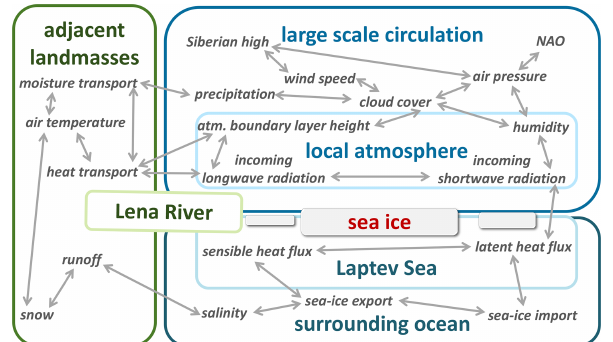
Figure 1. The regional climate system can be divided into general components (Laptev Sea, local atmosphere, adjacent land), which are embedded in the global climate system (surrounding ocean, atmospheric large-scale circulation) and interact with each other through a range of mechanisms including feedback loops; explana- tory links are indicated by grey arrows. All model variables used in the following analysis are listed in